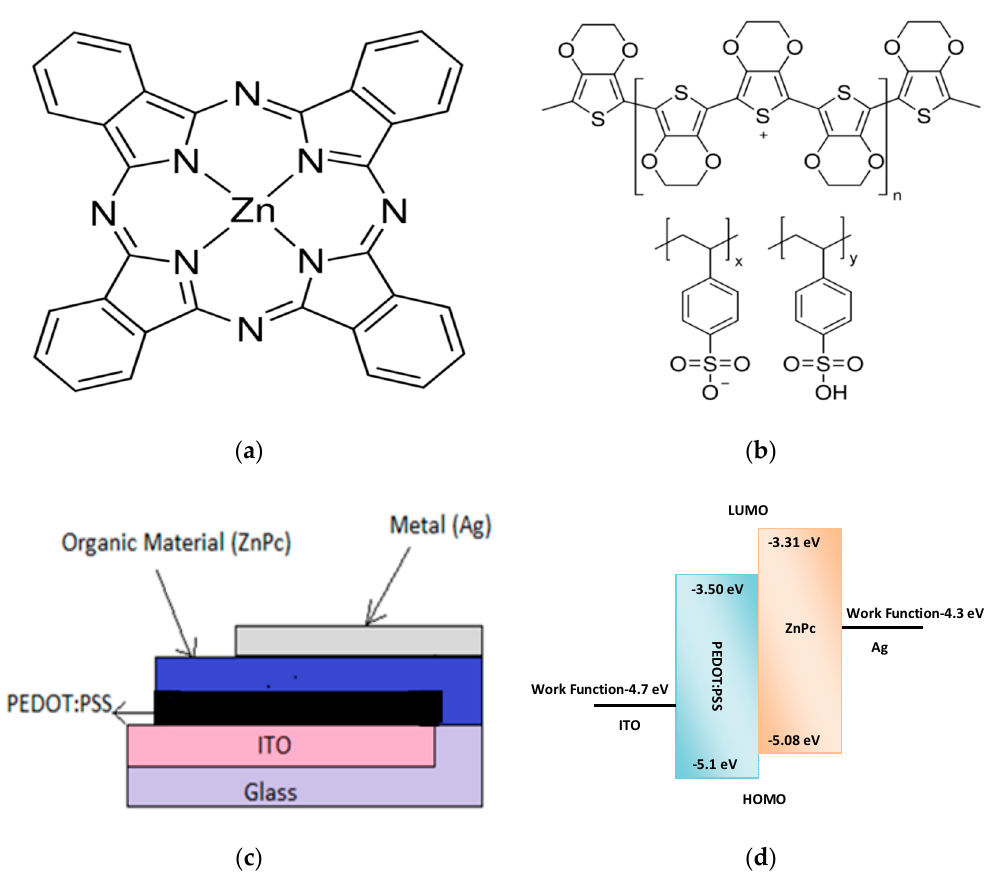
Figure 1. ( a ) Molecular structure of ZnPc; ( b ) molecular structure of PEDOT:PSS; ( c ) ZnPc based solar cell architecture; ( d ) energy band diagram of ITO/PEDOT:PSS/ZnPc/Ag solar cell.